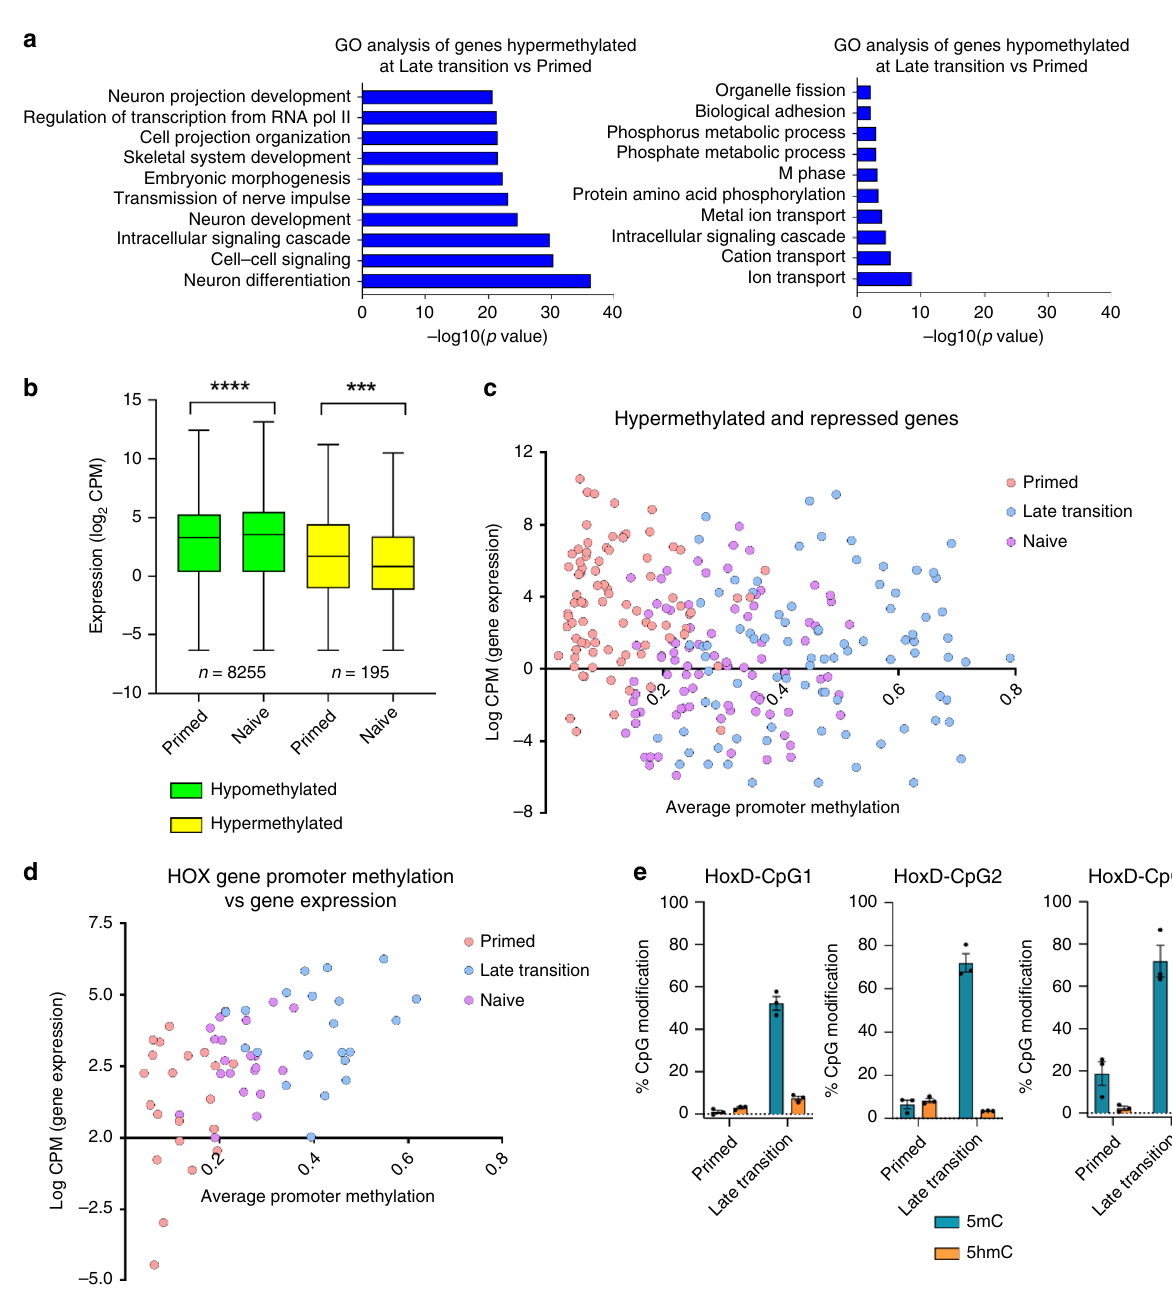
Fig. 2 Resetting results in hypermethylation and repression of developmental genes. a GO term analysis of hypermethylated and hypomethylated genes at the late transition of resetting compared to primed hESCs. A gene was classi fi ed as hypermethylated if a hypermethylated probe was present within 1500 bp upstream of the TSS. b Average gene expression for genes that are hypermethylated (average promoter methylation Δβ > 0.1) or hypomethylated (average promoter methylation Δβ < 0.1) in naïve compared to primed hESCs. Boxes represent the median and interquartile range and error bars represent the maximum and minimum values. Statistical signi fi cance determined via two-tailed paired Wilcoxon test. *** P < 0.001, **** P < 0.0001. CPM, Counts per Million. c Scatter plot of genes that are hypermethylated and downregulated showing the average promoter methylation (average β -value of CpG probes within 1500 bp of TSS) versus the log2 CPM (counts per million) for each gene from RNA-seq data. Data for each individual time point are indicated by the colour key. d Scatter plot showing the average promoter methylation of 21 HOX genes (average β -value of CpG probes within 1500 bp of TSS) versus the log2 CPM for each gene from RNA-seq data. Data for each individual time point are indicated by the colour key. e GlucMS-qPCR in primed and late transition hESCs showing the percentage of 5mC (blue) and 5hmC (orange) per CpG. Bars represent the mean of three biological replicates and error bars represent the SEM. Source data are provided as a Source Data fi